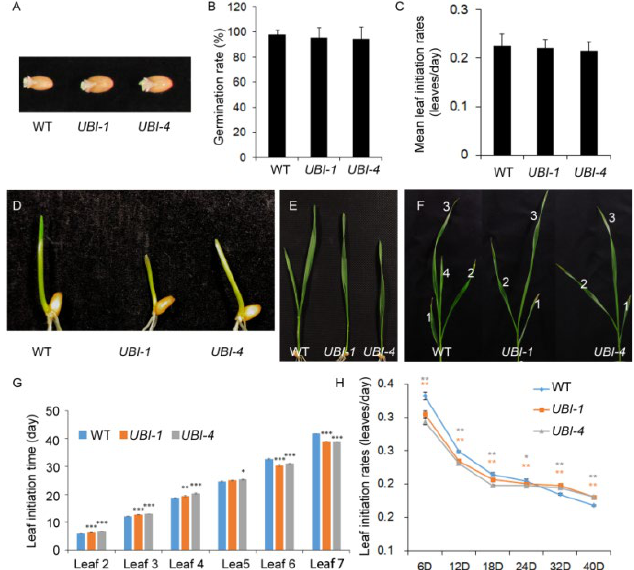
Figure 3. Overexpression of TaKLU in wheat influenced leaf initiation time of local leaves. ( A ) Com- parison of grain germination between WT and UBI::TaKLU plants at 24 h after sowing. ( B ) Statistics of germination rates of WT and UBI::TaKLU plants ( n > 20) at 24 h after sowing. ( C ) Statistics of mean leaf initiation rates of WT and UBI::TaKLU plants ( n > 10). ( D – F ) Comparison of growth status between WT and UBI::TaKLU plants at the seedling stage (The numbers in subfigure ( F ) indicate the order in which the leaves appeared). ( G ) Dynamic analysis of the leaf initiation time of WT and UBI::TaKLU plants ( n > 10). ( H ) Statistics of leaf initiation rates of WT and UBI::TaKLU plants after sowing ( n > 10). Bars indicate SE. Asterisks (*), (**), and (***) indicate significant differences from their WT at p < 0.05, p < 0.01, and p < 0.001 ( t -test),